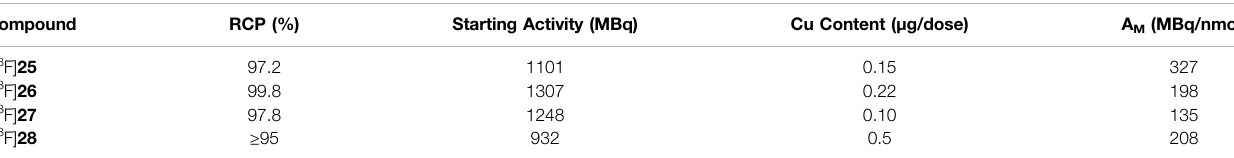
TABLE 4 | Quality control results of radiolabeleld compounds. Compound RCP (%) Starting Activity